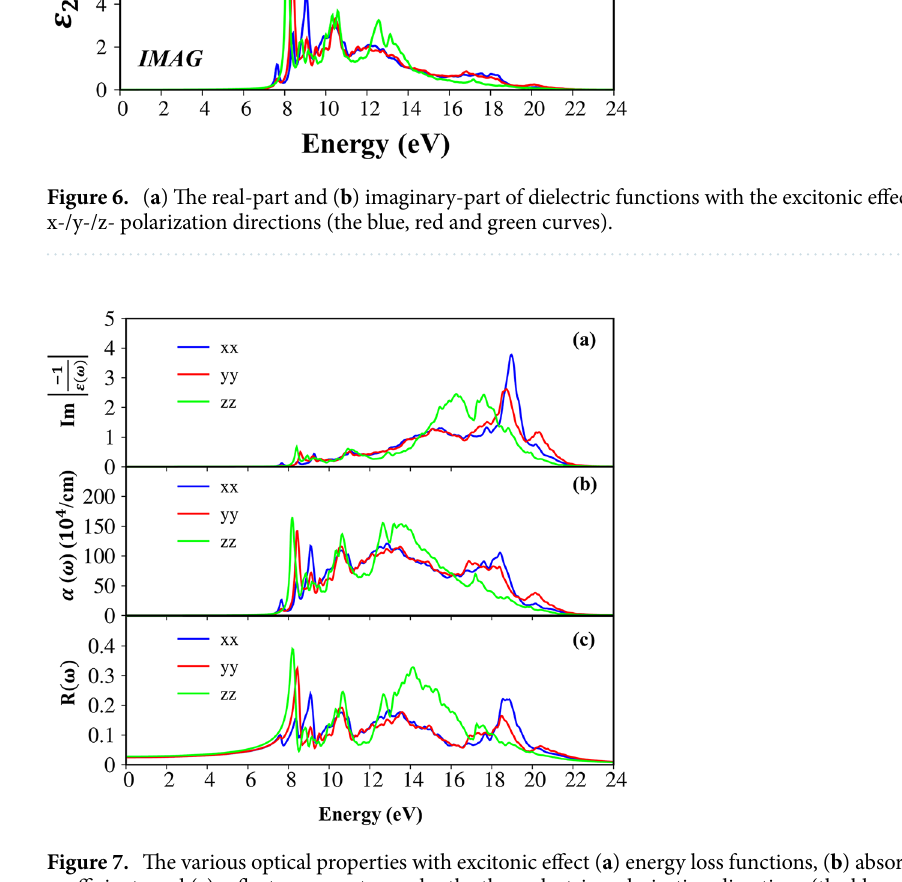
Figure 7. The various optical properties with excitonic effect ( a ) energy loss functions, ( b ) absorption coefficients and ( c ) reflectance spectra under the three electric-polarization directions (the blue, red and green